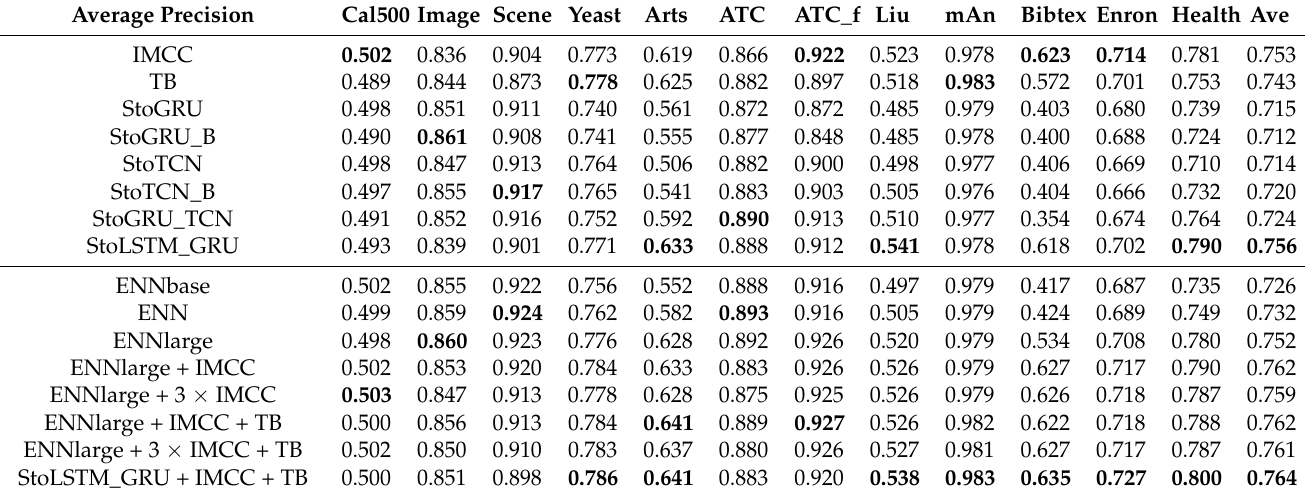
Table 5. Average precision of the ensembles and state of the art on the twelve benchmarks (boldface values indicate the best performance within each group of similar approaches). Bold highlights superior